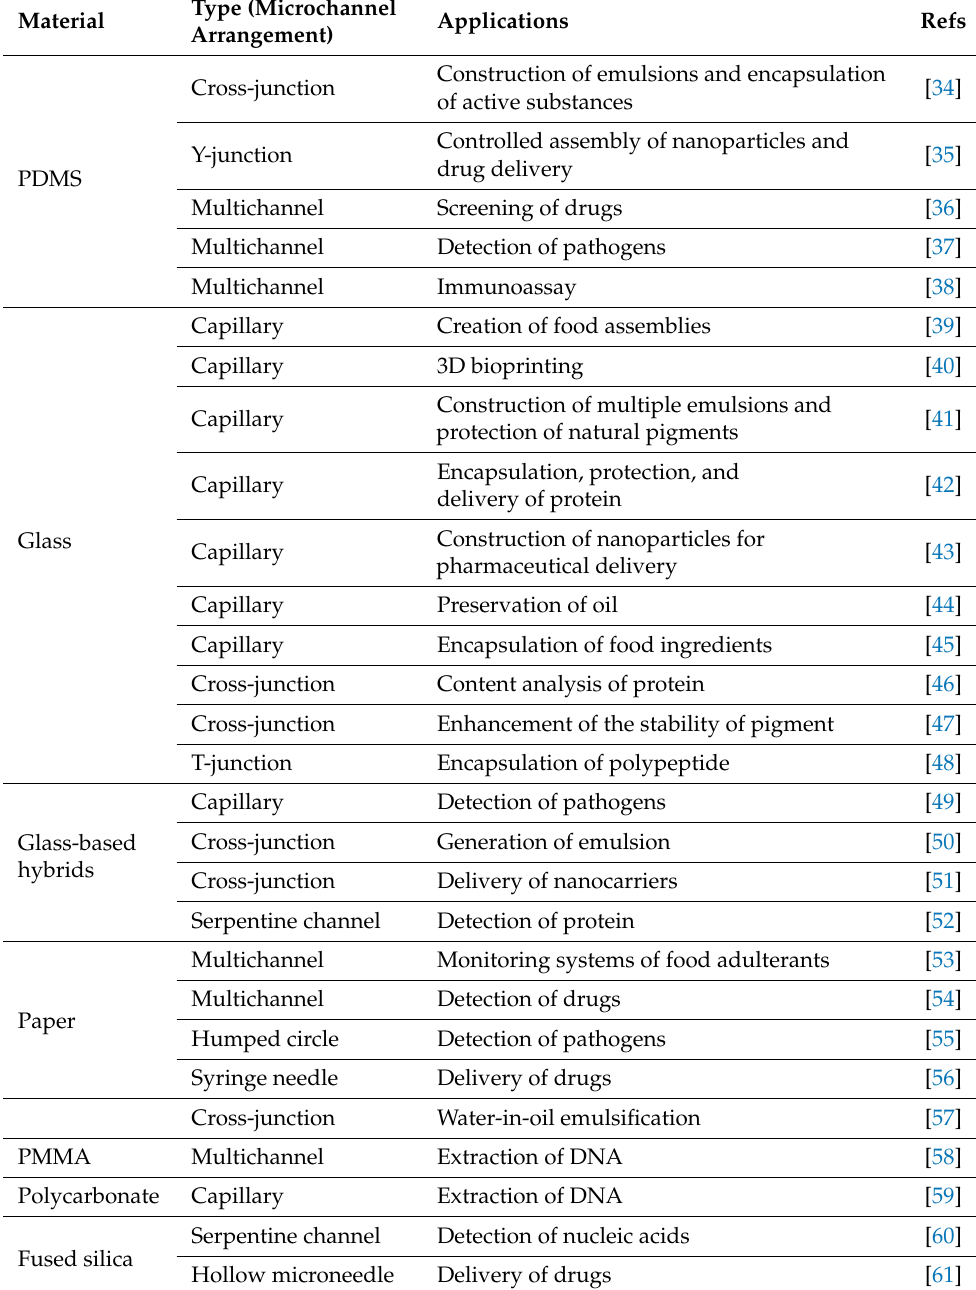
Table 1. Summary of the microfluidic platforms applied in food processing and